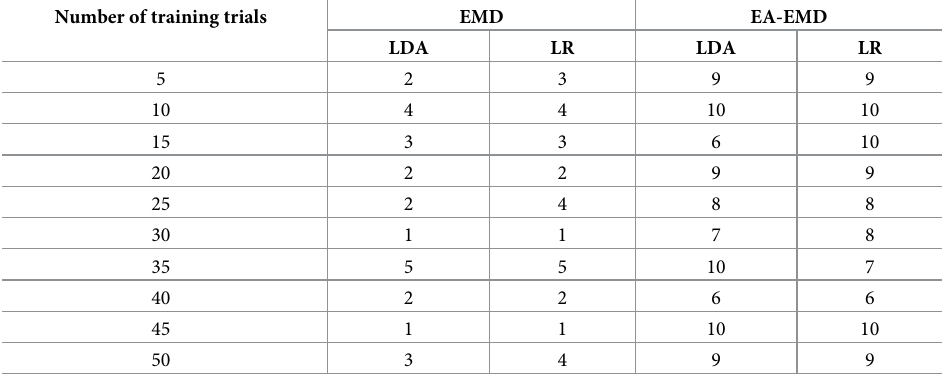
Table 3. Best multiples of artificial frames yielded by EMD and EA-EMD at each number of training trials for dataset 1.